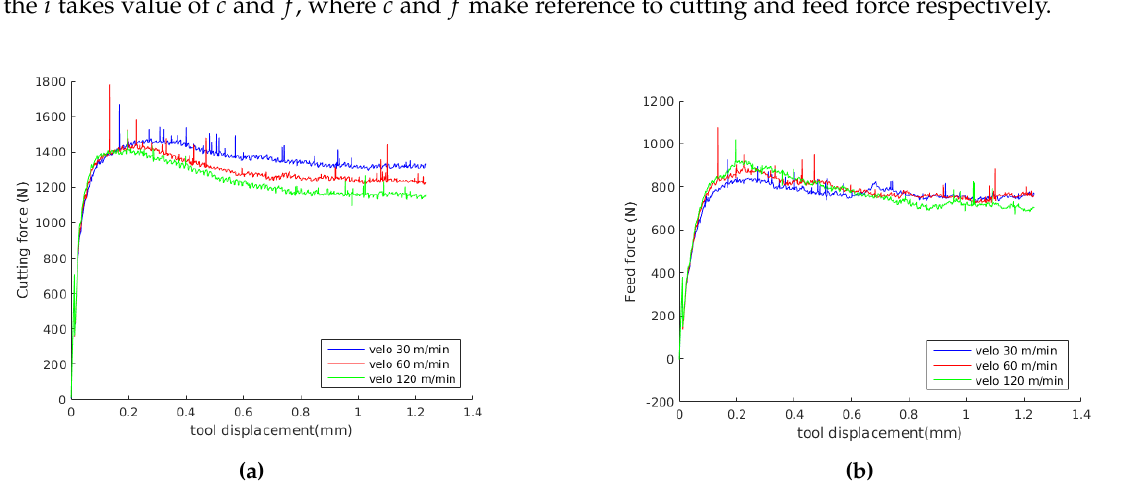
Figure 9. Predicted forces using the Johnson-Cook model with our parameters 7 (see Table 1); ( a ) cutting, ( b ) feed.